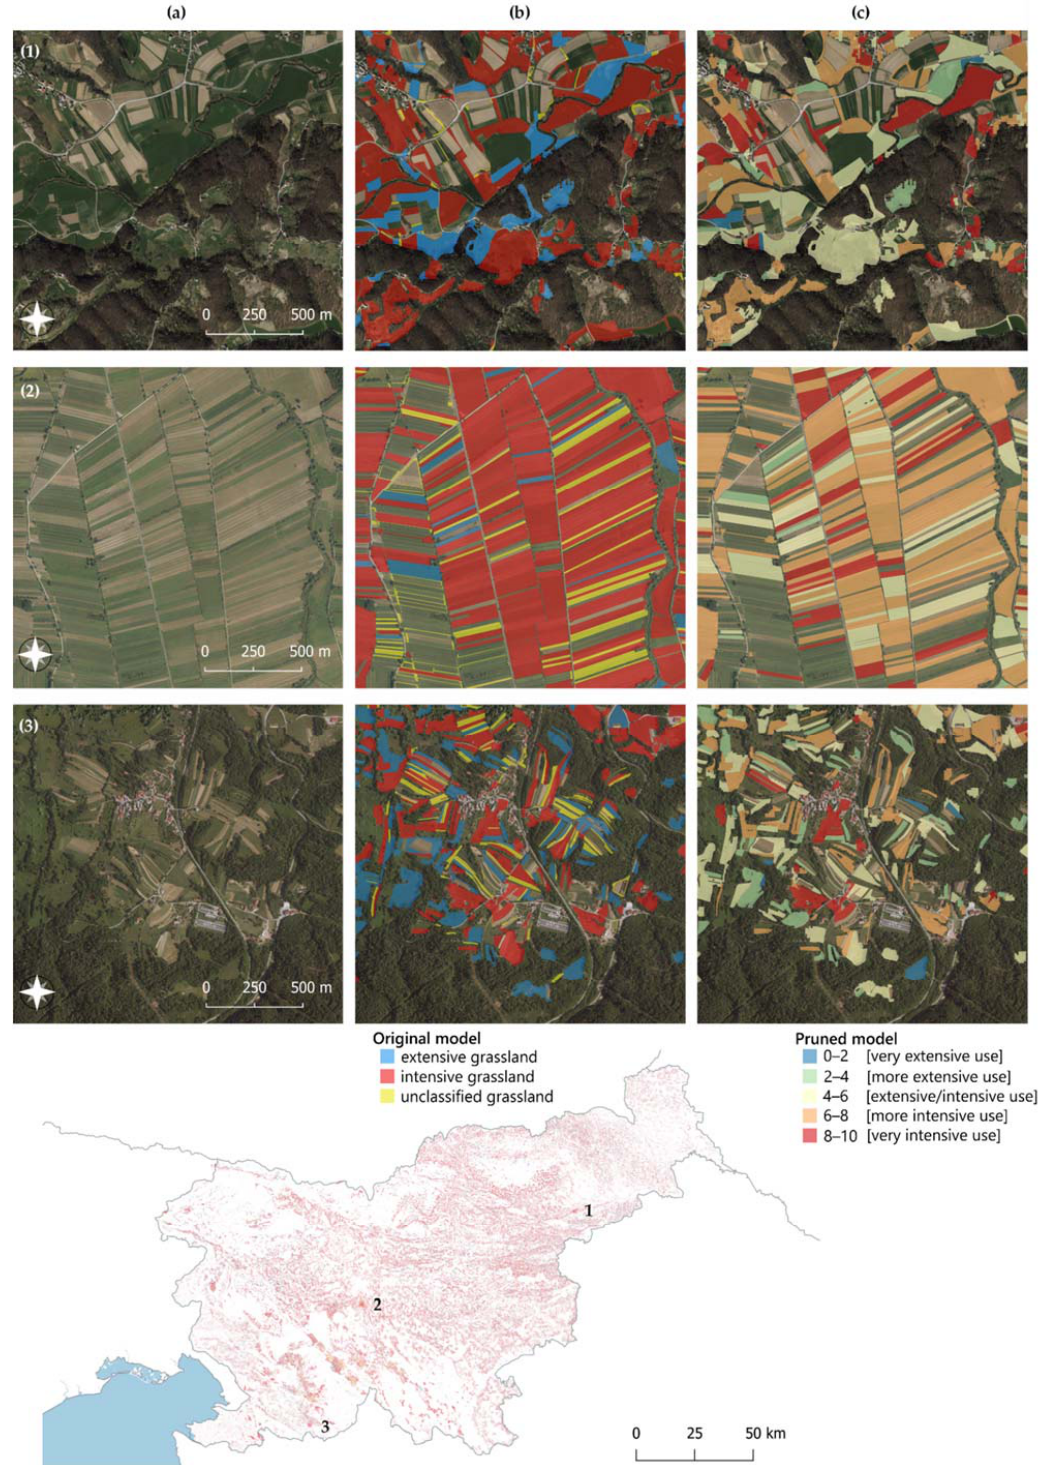
Figure 8. Permanent grassland classification results for representative subsets of the study area. ( a ) Orthophoto, ( b ) intensive and extensive grassland use classification results for 2019 and ( c ) confidence interval value associated with the prediction. The representative subsets of the study area have different relief characteristics and management practices. Subset at the top is a mix of flat and rugged terrain, subset in the middle represents flat terrain, and subset at the bottom represents rugged Karst